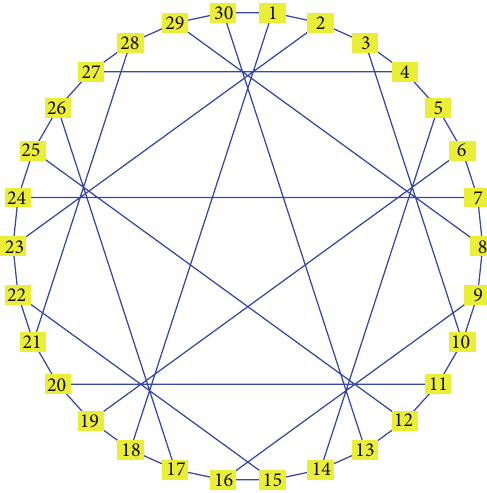
Figure 4: Levi graph: original style.